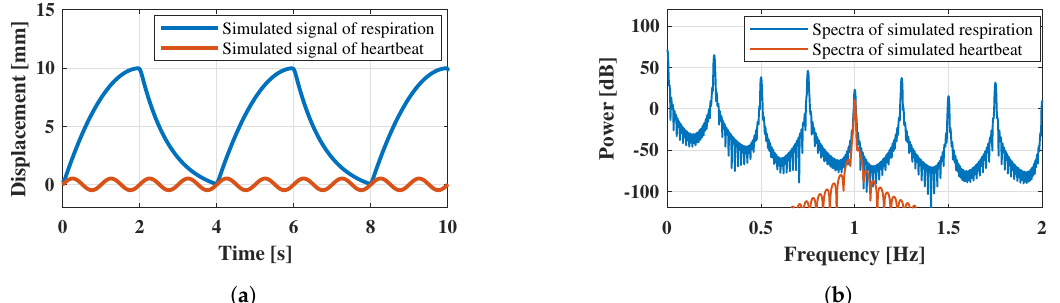
Figure 3. Simulated chest surface oscillations caused by breathing and heartbeat: ( a ) shows the signal in the time domain and ( b ) shows the spectrum in the frequency domain.